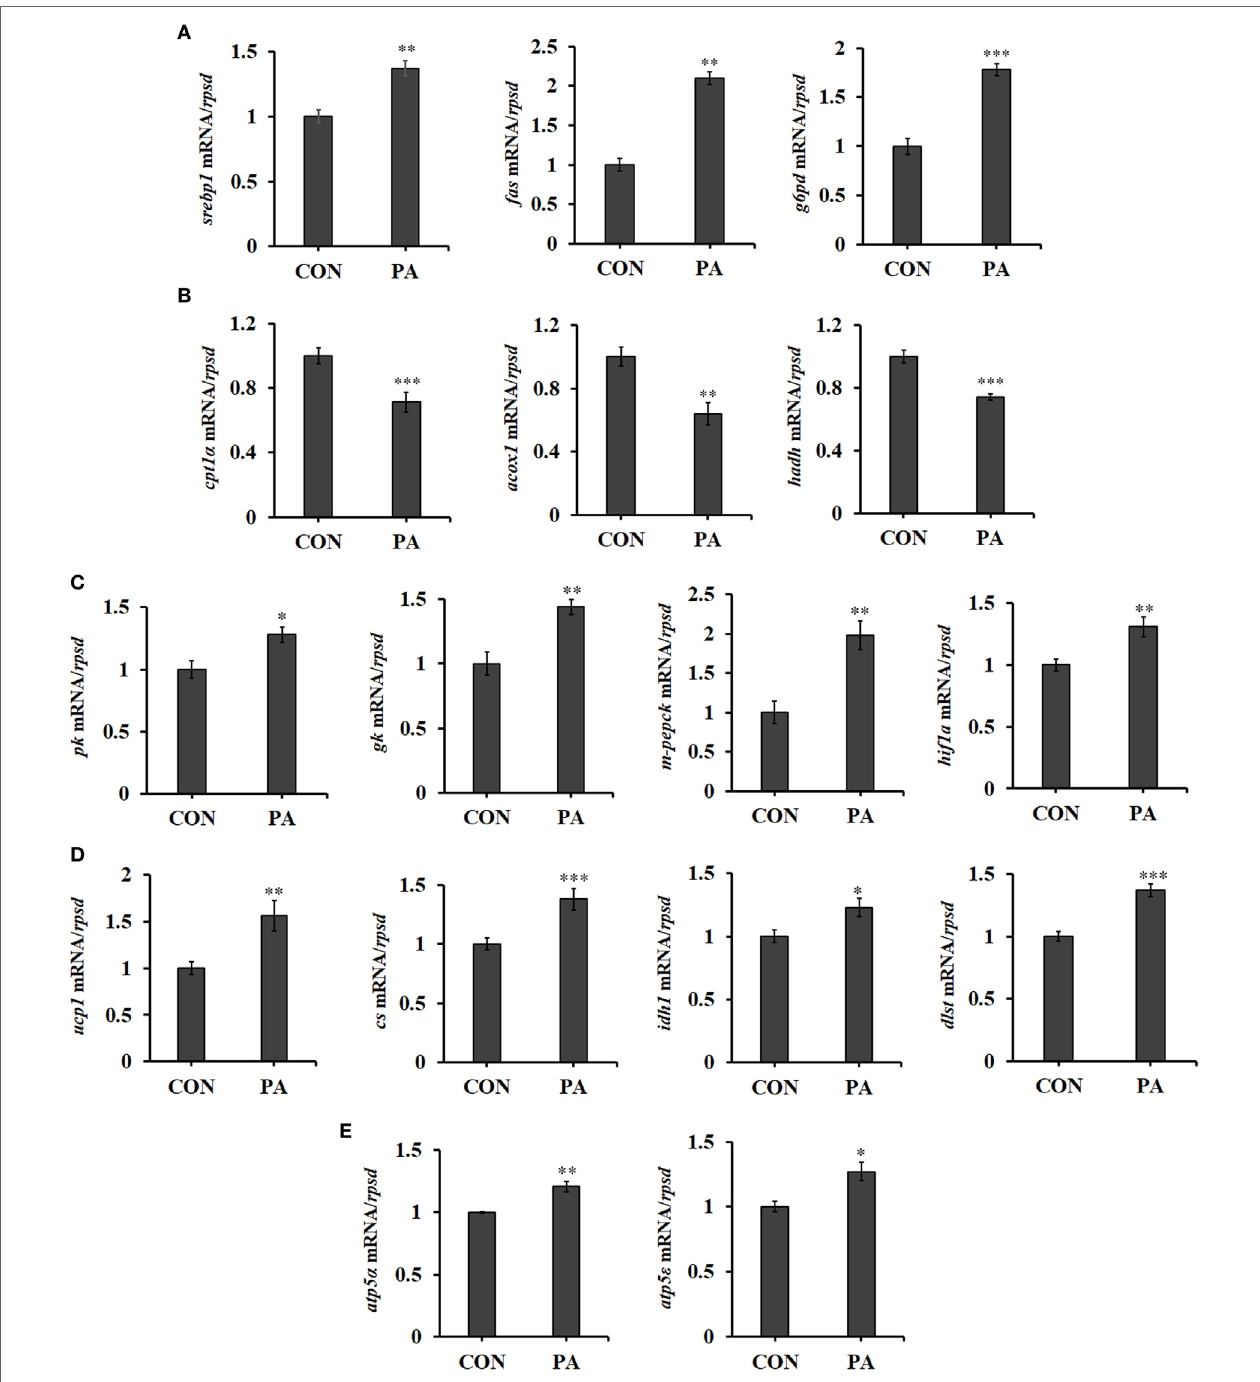
FigUre 6 | Phosphatidic acid (PA) influenced fatty acid metabolism, glycolysis, and energy metabolism. The mRNA expressions of (a) sterol regulatory element- binding protein 1 (srebp1) , fatty acid synthetase (fas) , glucose-6-phosphate dehydrogenase (g6pd) , (B) cpt1 α , acox1 , hadh , (c) pk , gk , m-pepck , hypoxia-inducible factor 1-alpha (hif1 α ) , (D) ucp1 , cs , idh1 , dlst , (e) atp5 α , and atp5 ε were analyzed by quantitative real-time PCR after PA treatment ( n = 6). Results were represented as means with SEs and were analyzed using independent t tests (* P < 0.05, ** P < 0.01, *** P < 0.001).